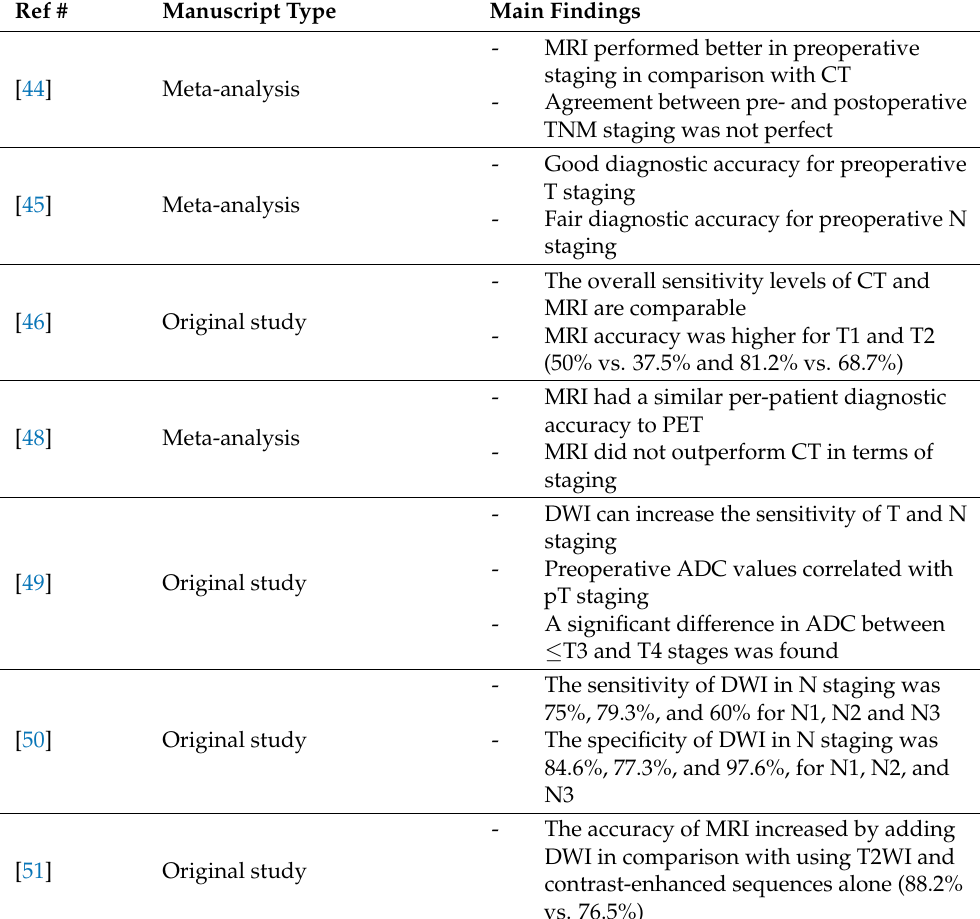
Table 4. Details of the most important papers regarding the usefulness of MRI in the staging of GC